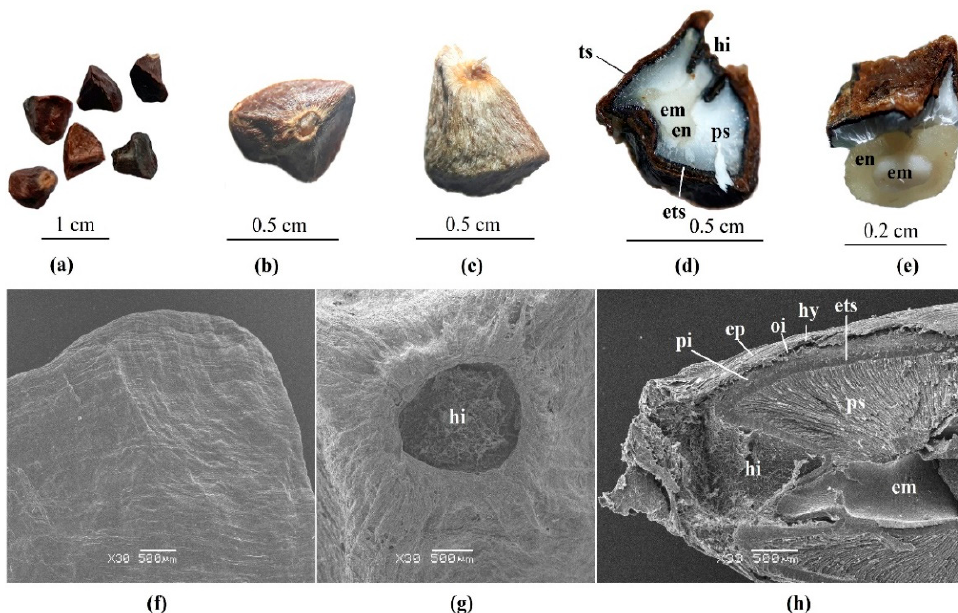
Figure 2. Black cardamom seeds: ( a , b ) morphological characteristics of seeds; ( c ) seed covered by arillus; ( d , e ) anatomical characteristics of seeds under the stereomicroscope: ts—testa, ets—endotesta, hi—hilum, ps—perisperm, en—endosperm, em—embryo; ( f – h ) anatomical characteristics of seeds under the SEM: ep—epidermal cells of testa, hy—hypodermis, oi—oil cell layer, pi—pigment layer. Scale bars ( f – h ) = 500 µm.